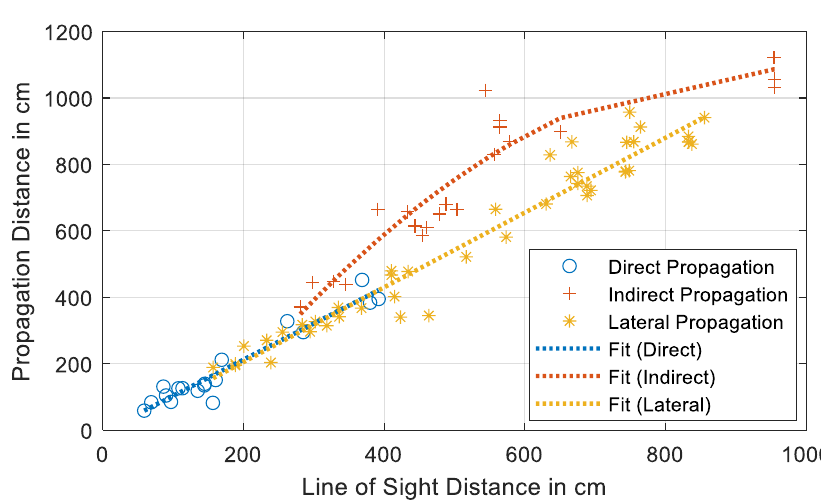
Figure 11. Relationship between propagation distance and LoS distance.